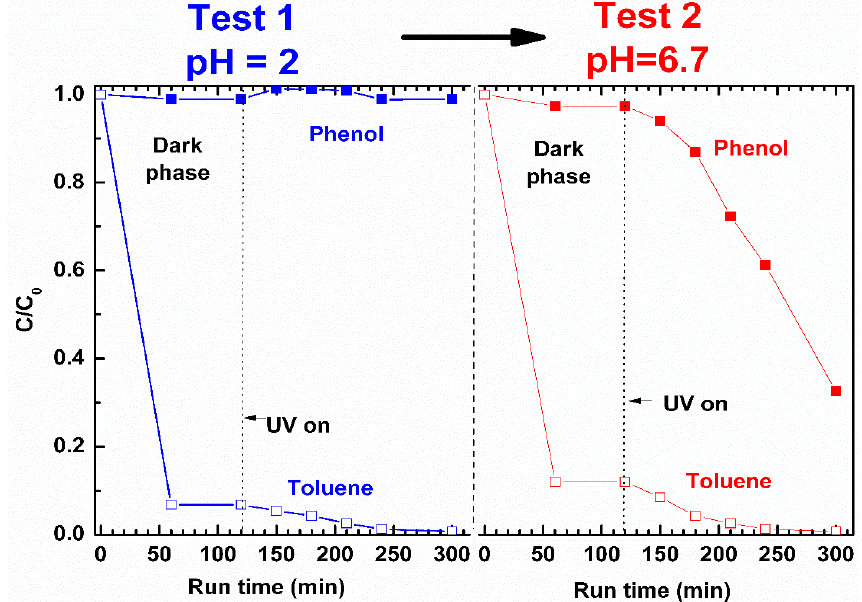
Figure 11. Toluene (open symbols) and phenol (closed symbols) concentration, in binary aqueous solutions at pH = 2 ( left ) and pH = 6.7 ( right ), containing 50 mg/L of both target molecules, treated with 2ZnO/s-PS δ -form aerogel.